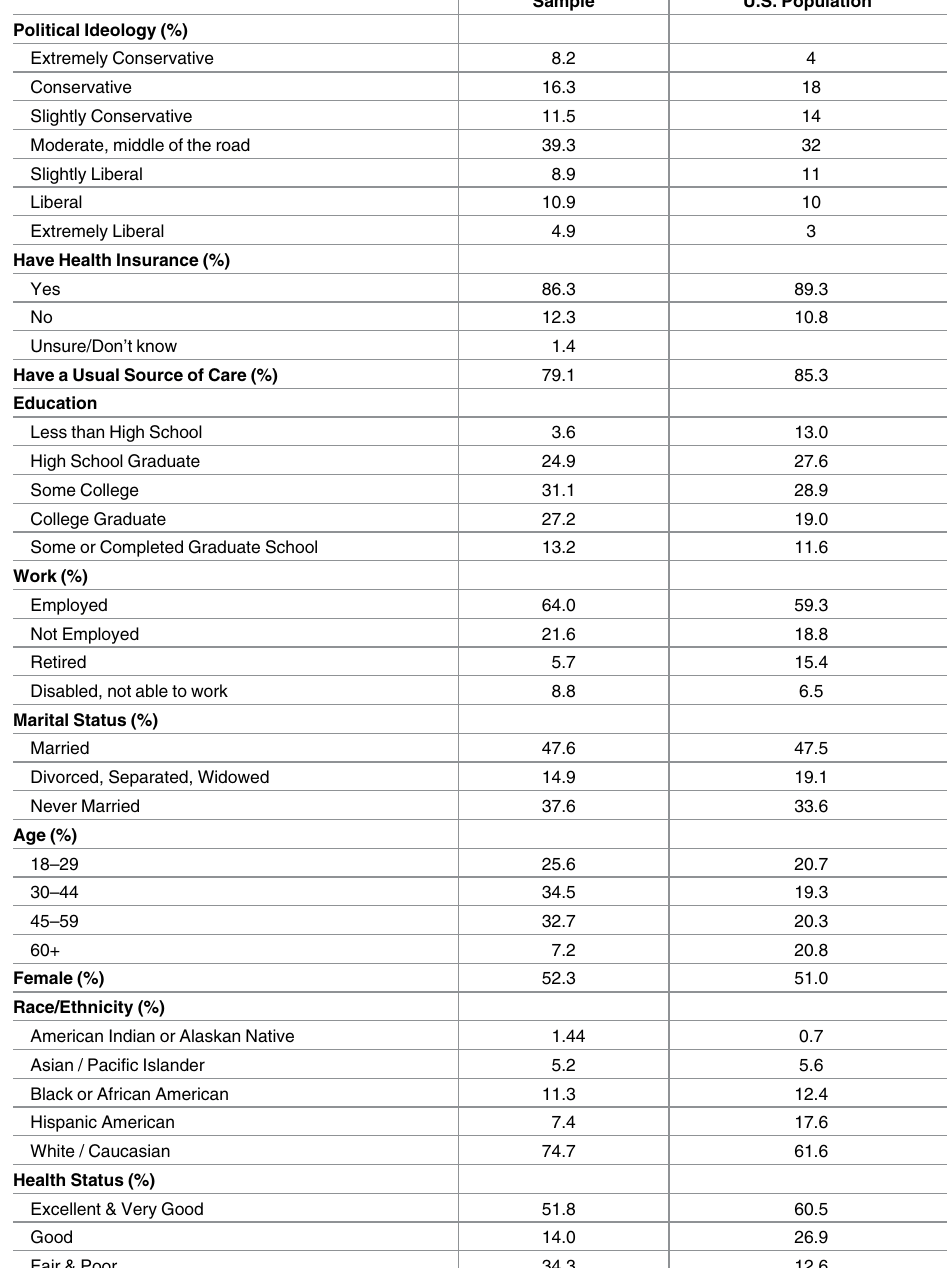
Table 1. Sample characteristics and comparison to U.S. non-institutionalized civilian population 18 yearsor